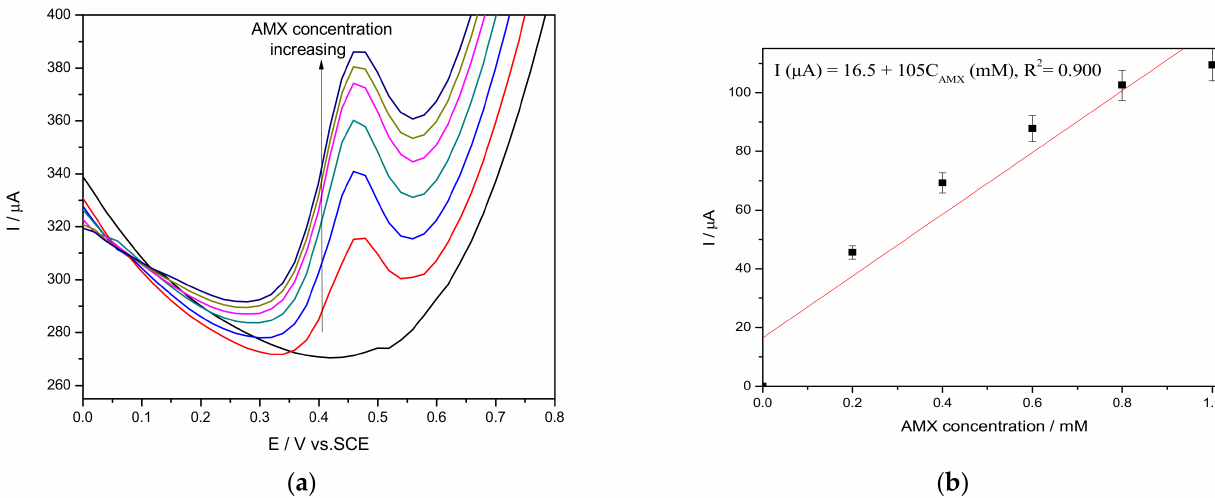
Figure 8. ( a ) Differential-pulse voltammograms recorded on the CuBi/CNF electrode in 0.1 M Na 2 SO 4 supporting electrolyte in the presence of various AMX concentrations: 0.2 mM, 0.4 mM, 0.6 mM, 0.8 mM, 1.0 mM, and 1.2 mM. SP of 0.02 V and MA of 0.10 V. ( b ) Calibration plots for AMX detection in the concentration range of 0.2–1.2 mM recorded at the potential value of E = +0.500